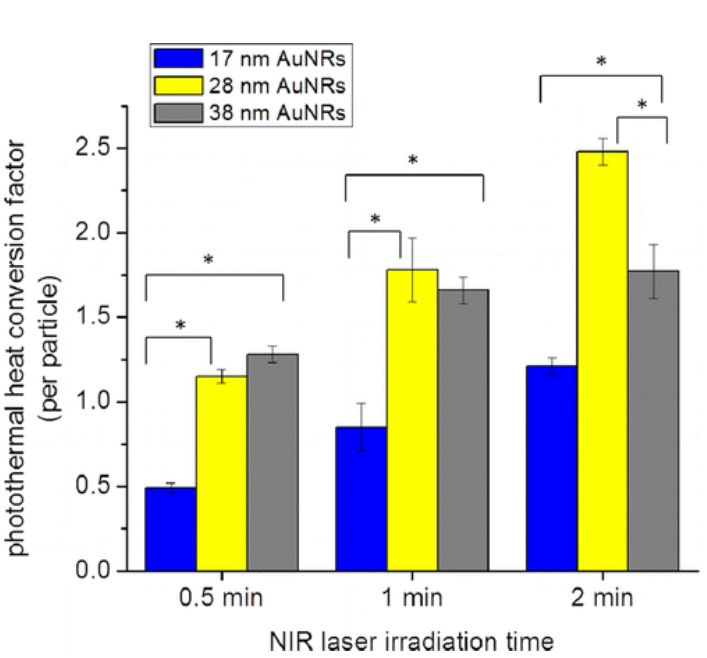
Figure 2: Comparison of Photothermal Heat Conversion Factors Based on Irradiation Times with a NIR Laser and the Size of AuNRs